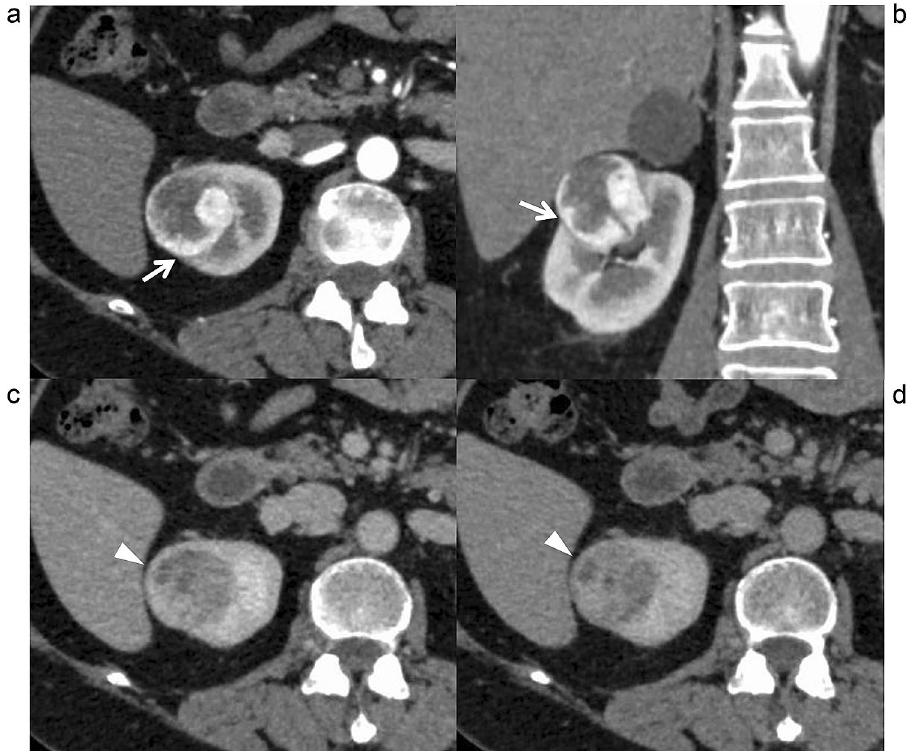
Figure 3. Contrast-enhanced computed tomography of a clear cell renal cell carcinoma without a pathological peritumoral pseudocapsule in a 53-year-old women. A thin low-attenuation rim is observed partly between the tumor and renal cortex (arrows) on the cortico-medullary phase trans-axial ( a ) and coronal images ( b ). A suspected high-attenuation rim is observed on the nephrographic ( c ) or excretory phase ( d ) images. These findings represent false-positive results of a